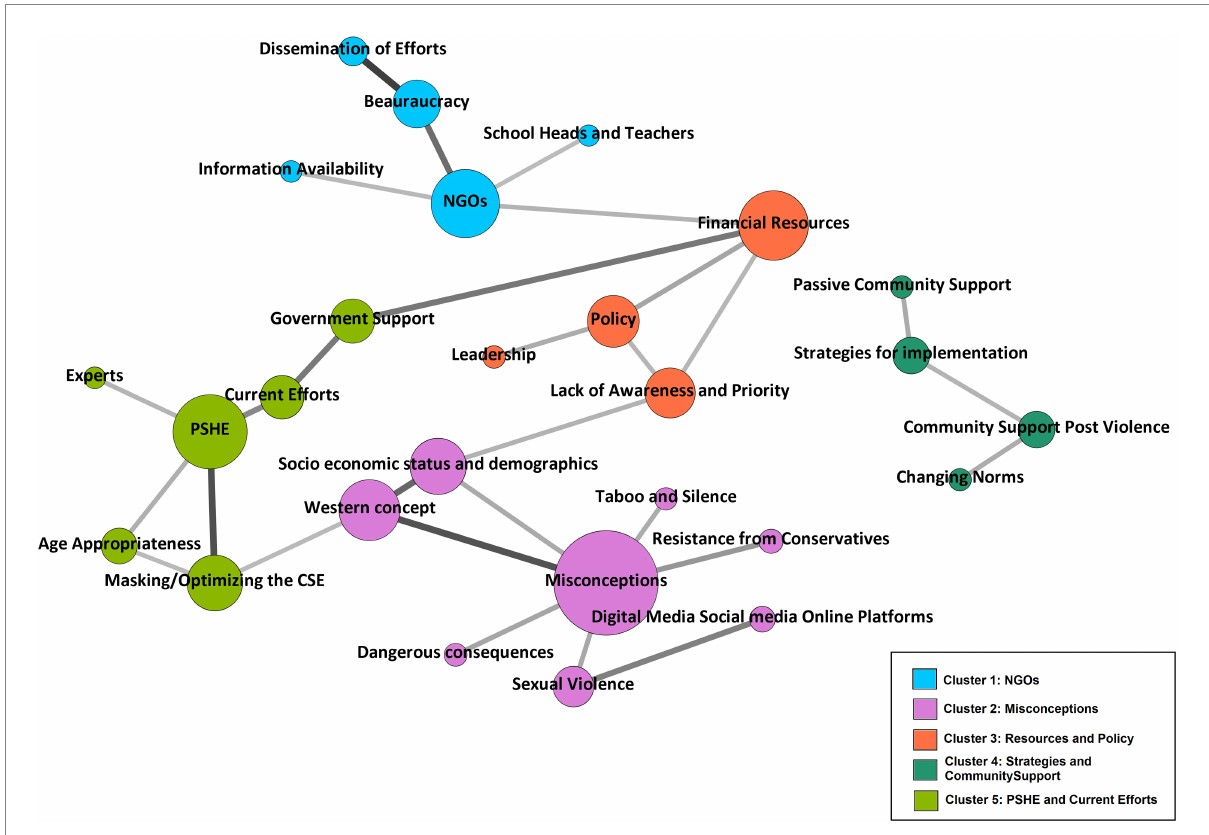
FIGURE 2 Network analysis and